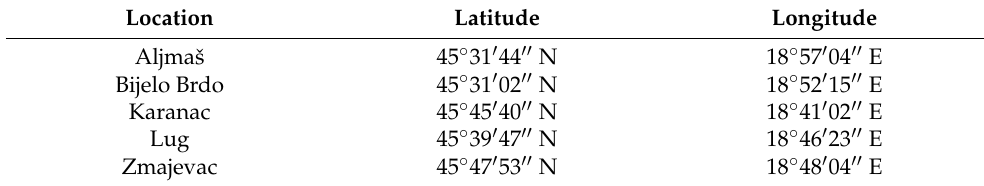
Table 1. Geographical coordinates of the study